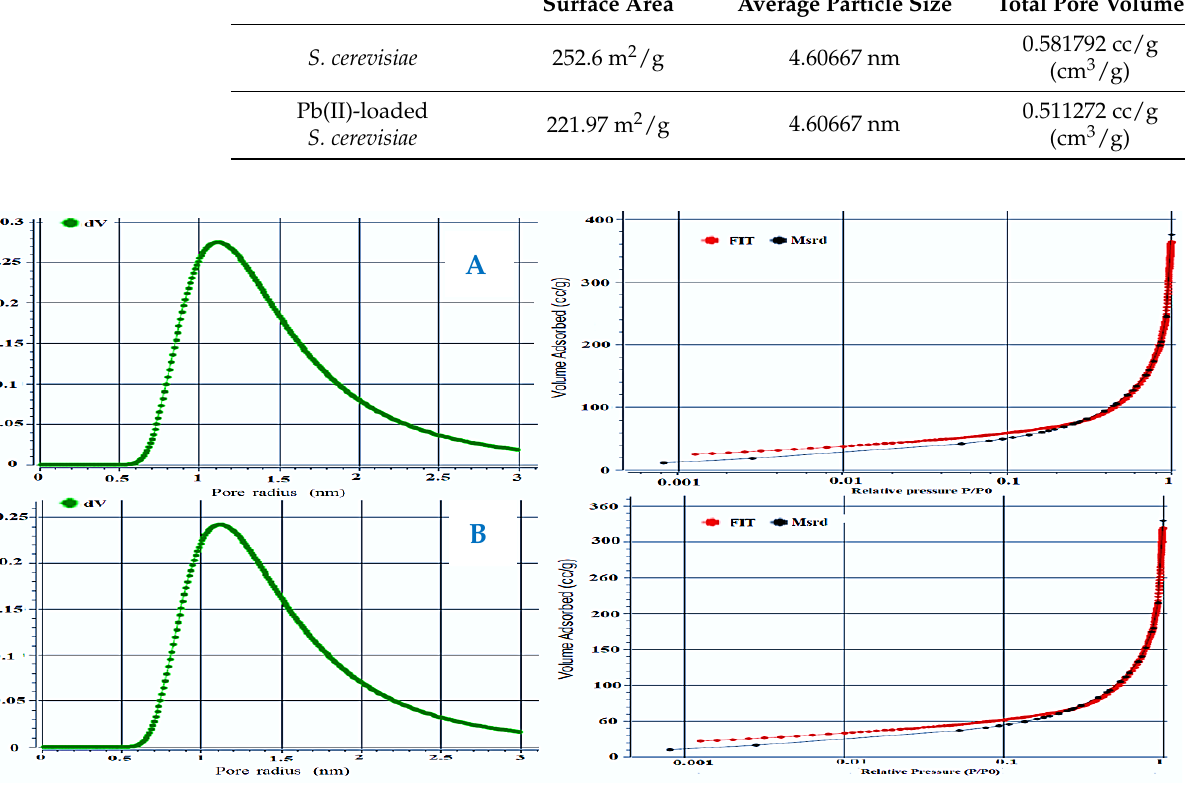
Figure 8. N 2 sorption isotherms for the hydrothermal alkali-activation products of S. cerevisiae ( A ) and Pb-loaded S. cerevisiae biomass ( B ). Table 6. Brunauer – Emmett – Teller (BET) analysis for raw and Pb(II)- S. cerevisiae biomass.